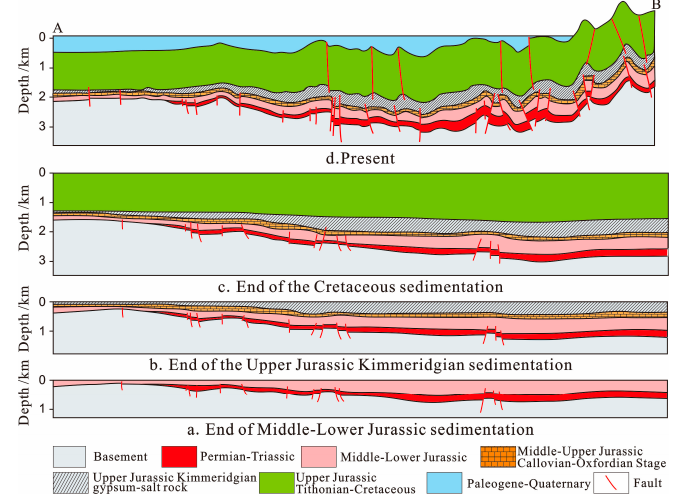
Figure 2. Palinspastic sections in Amu Darya Basin, location of profile is shown in Figure 1 (Reference [27,28]).